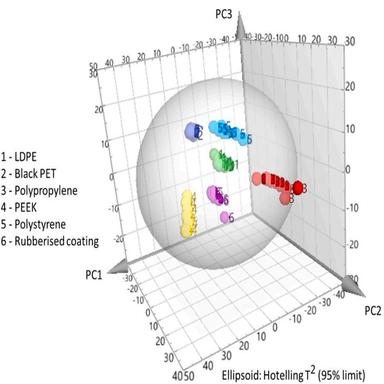
PCA analysis of Raman spectra measured by the Raman probe setup, shows discrimination between all the different samples, made up of six different materials. The first three principal component (PC) explained 65% of the variance in the Raman data.